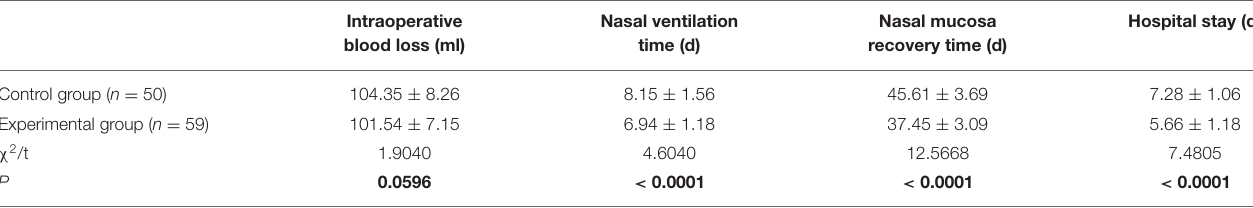
TABLE 2 | Comparison of clinical indices of patients between the two